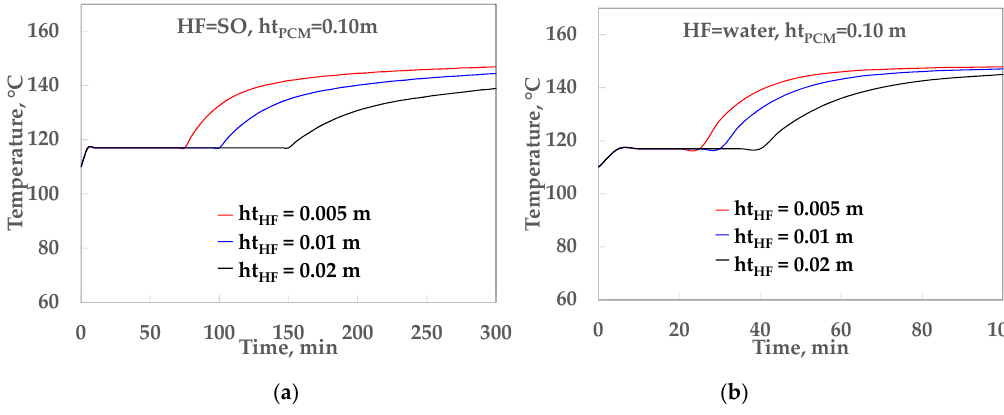
Figure 10. Temperature profile over time for a height of PCM = 0.10 m using ( a ) SO and ( b ) water.